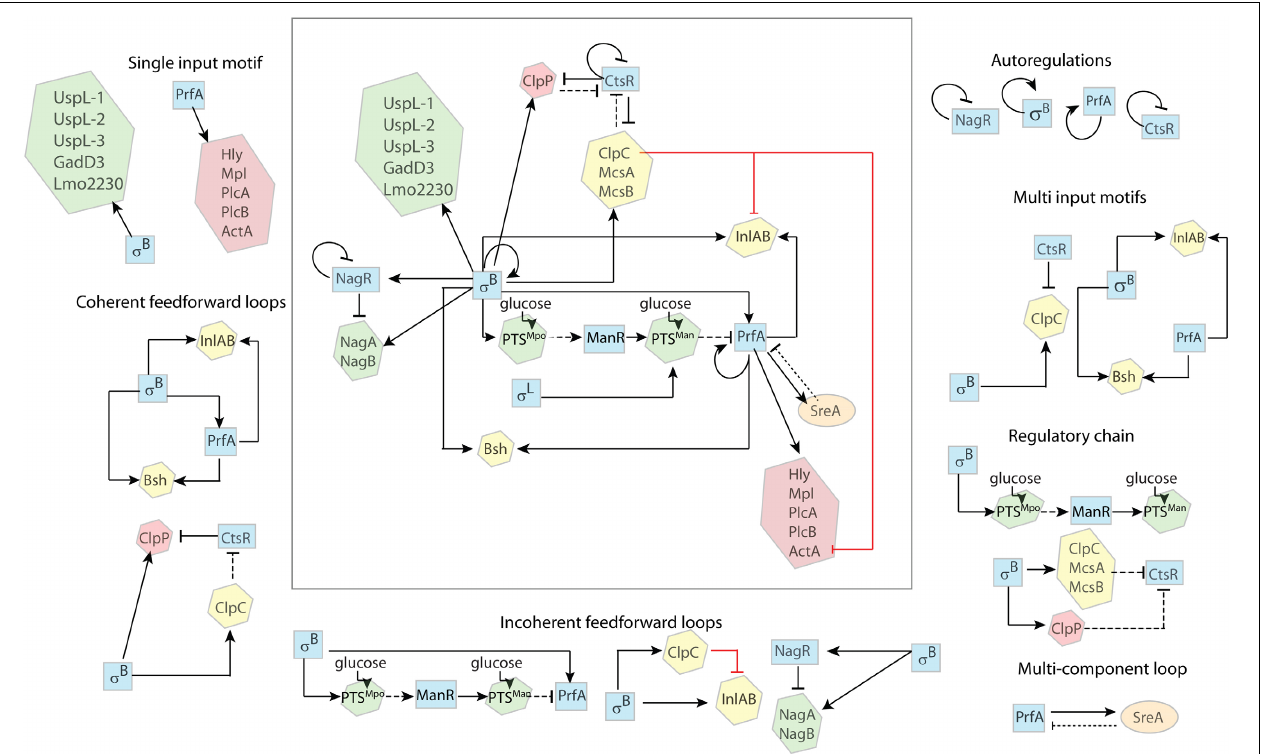
FIGURE 2 | Regulatory features in L. monocytogenes . The regulatory network involves six transcriptional regulators; the alternative σ factors σ B and σ L , the transcription activators PrfA and ManR, and the transcription repressors CtsR and NagR (blue squares). Proteins not involved in transcription regulation are enclosed in hexagons. Proteins mostly active during environmental growth (green) include NagA, an N-acetyl-glucosamine- 6-phosphate deacetylase, NagB, a glucosamine-6-phosphate deaminase, PTS Mpo and PTS Man , two glucose PTSs; ClpC, a protease, InlA and InlB, two internalin proteins, and Bsh, a bile salt hydrolase, are involved in the early stages of infection (yellow); ClpP is a serine protease and Hly, Mpl, PlcA,